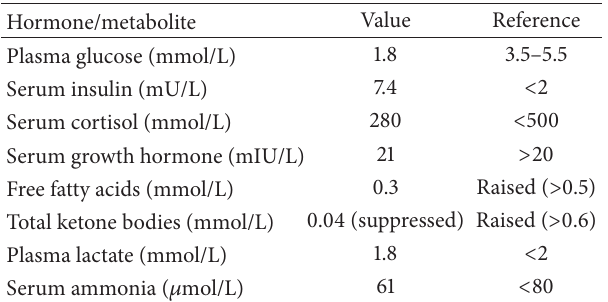
Table 1: Results of the metabolites and hormones measured at the time of hypoglycemia in our